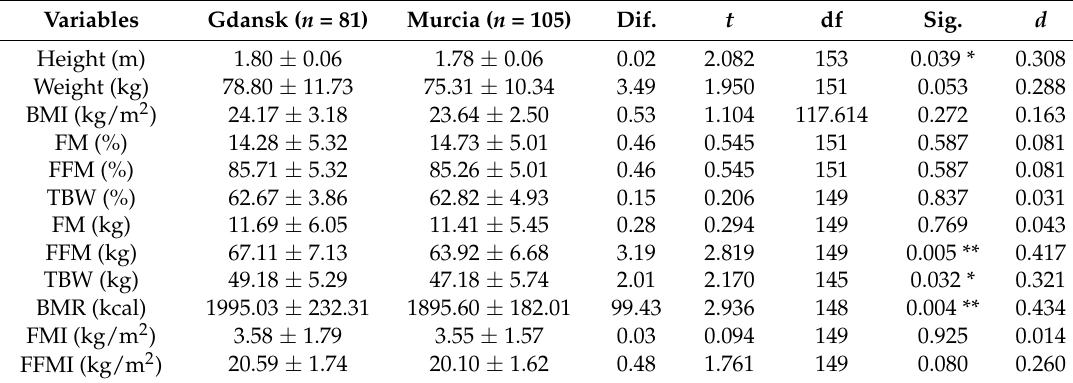
Table 1. Comparison of body composition of males from Gdansk and Murcia.